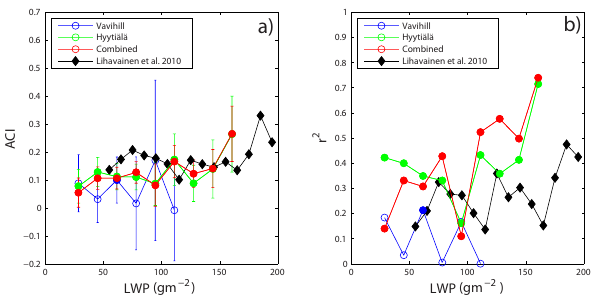
Figure 7. (a) Aerosol–cloud interaction (ACI) as a function of liq- uid water path (LWP) and (b) the corresponding squared correla- tion coefficients ( r 2 ) as a function of LWP for Vavihill (blue) and Hyytiälä (green) separately and combined (red). The ACI is cal- culated with α equal to N 130 . Results obtained by Lihavainen et al. (2010) (black) are also included in the figure. Filled markers in the figure denote statistically significant correlations at a 95% con- fidence